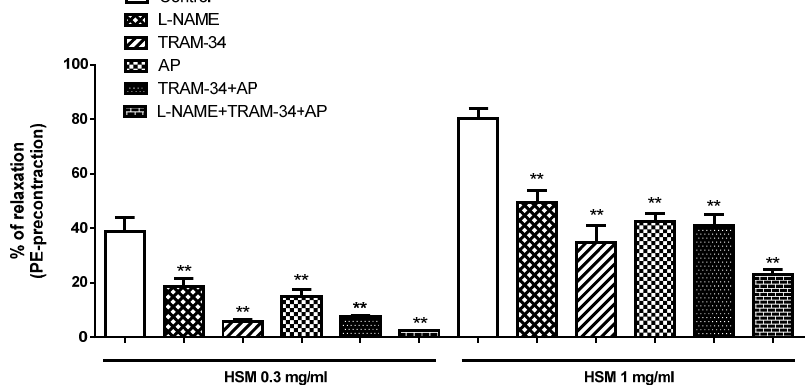
Figure 8. The effects of preincubation with L-NAME (10 µ M), TRAM-34 (1 µ M), apamin (AP, 1 µ M) and the combination of TRAM-34+AP and L-NAME+TRAM-34+AP on the vasorelaxant response evoked by H. stoechas (HSM; 0.3 and 1 mg/mL) in isolated rat rings precontracted with PE (HSM 0.3 mg/mL; F = 51.45, p < 0.0001 and HSM 1 mg/mL; F = 48.19, p < 0.0001). Data are mean ± SEM ( n = 6–8). ** p < 0.01 vs. control.